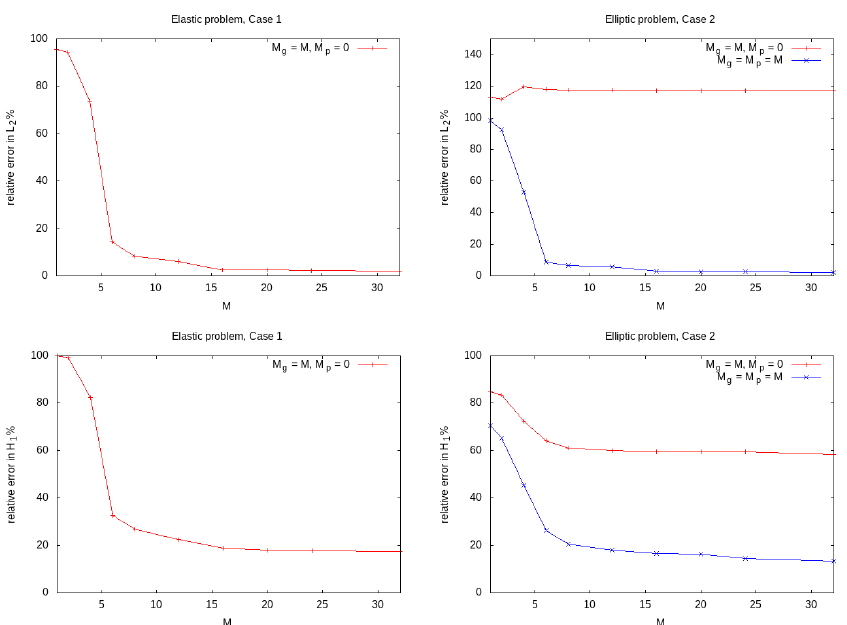
Figure 13. Elasticity problem. Case 1 ( left ) and Case 2 ( right ): Relative L 2 ( top ) and H 1 ( bottom ) error with a different number of multiscale basis functions.